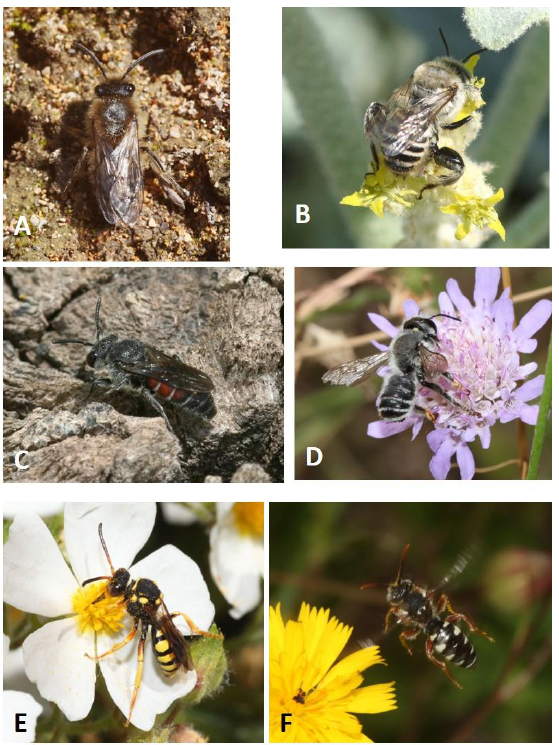
Figure 4. New species of pollinators (Hymenoptera: Apoidea) for Sardinia: ( A ) Colletes cunicularius ; ( B ) Lithurgus tibialis ; ( C ) Dioxys cinctus ; ( D ) Megachile ericetorum ; ( E ) Nomada melathoracica ; and ( F ) Nomada pulchra (Photos: Pietro Niolu). Table 2. Comparison between data on the presence (x) of the twenty species of Apoidea in Italy and in Mediterranean coutries.